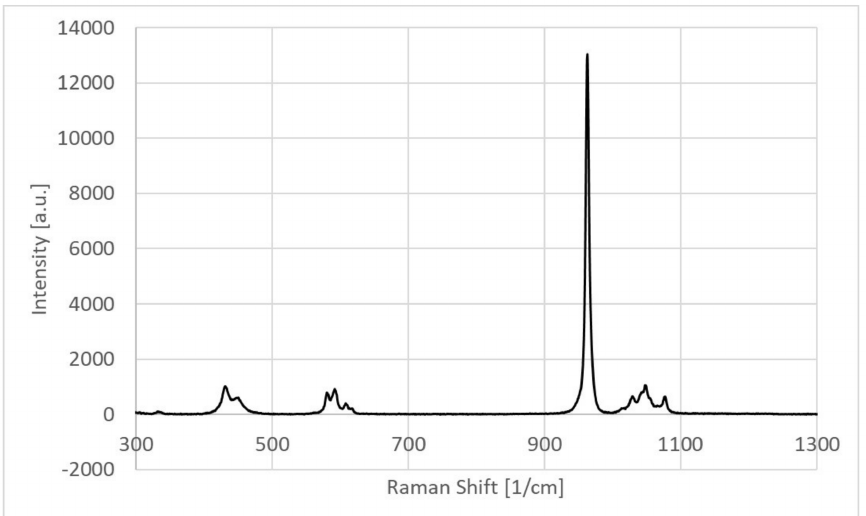
Figure 5. Micro-Raman spectra of the CBHA